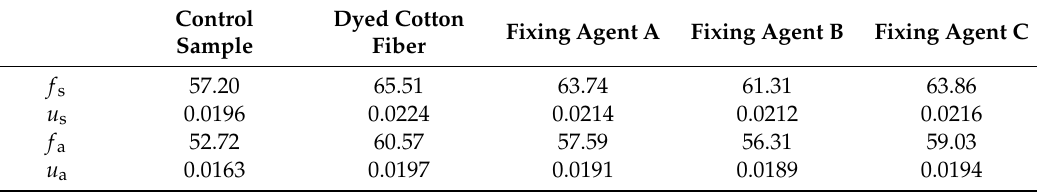
Table 2. The coe ffi cient of friction on cotton fiber after fixing finishing. Table 2. The coefficient of friction on cotton fiber after fixing finishing.